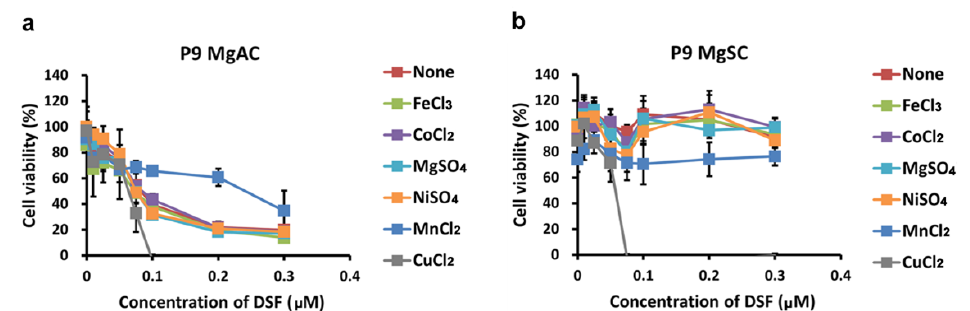
Figure 4. Effect of various metal ions on the cytotoxicity of the DSF/metal ion complex. MgACs ( a ) and MgSCs ( b ) were incubated for 48 h with different concentrations of DSF (0 µ M, 0.01 µ M, 0.025 µ M, 0.05 µ M, 0.075 µ M, 0.1 µ M, 0.2 µ M, and 0.3 µ M) and 1 µ M FeCl 3 , CoCl 2 , MgSO 4 , NiSO 4 , or MnCl 2 . Cell viability was assessed with MTS assays. Results are presented as the mean ± SD of triplicate samples from representative data from three independent experiments.